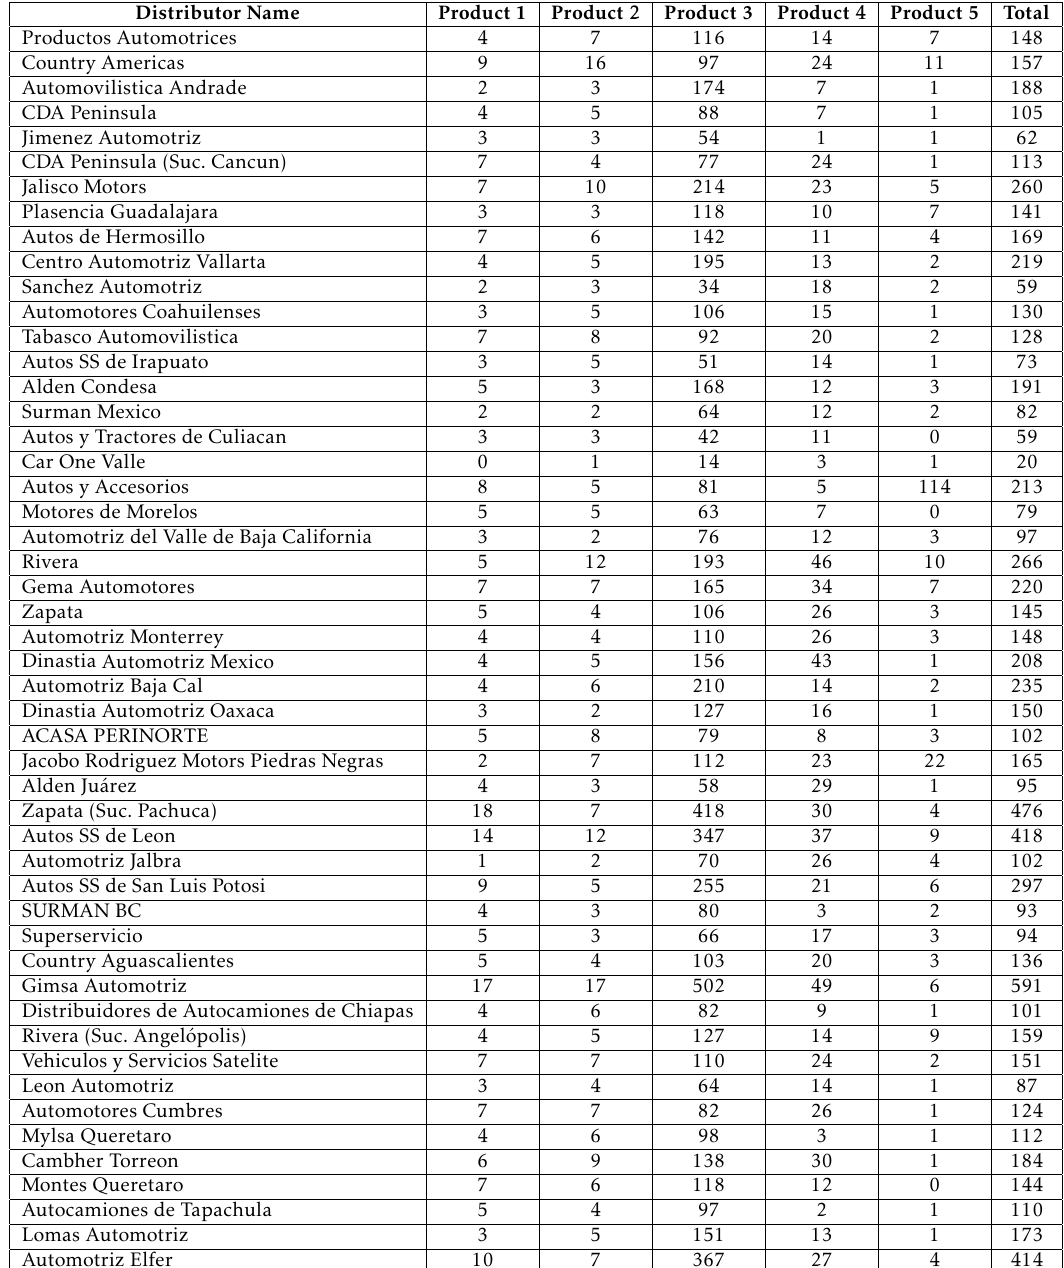
Table 6. Sales forecast per vehicle by